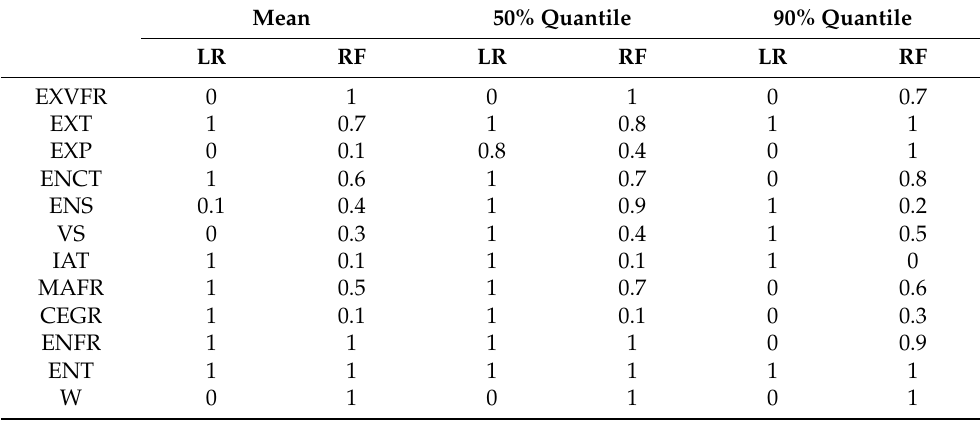
Table 5. Frequency of features selected.